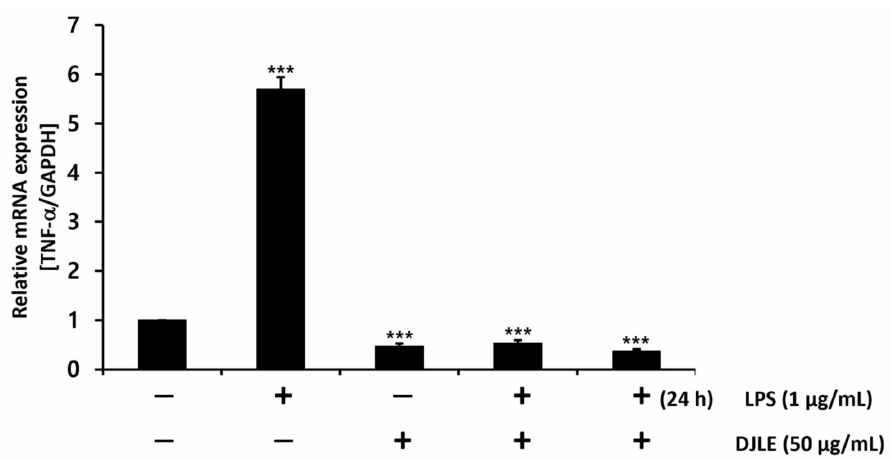
Figure 4. Effect of Daphne jejudoensis leaf extract (DJLE) on tumor necrosis factor (TNF)- α gene expression under LPS-induced inflammation in human periodontal ligament cells. *** p < 0.001 vs.